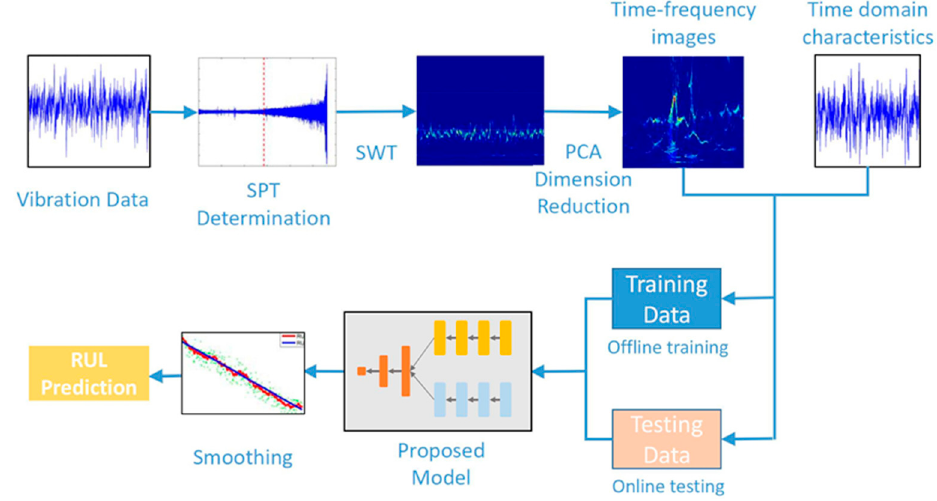
Figure 3. Flow chart of the proposed method for prognostics.